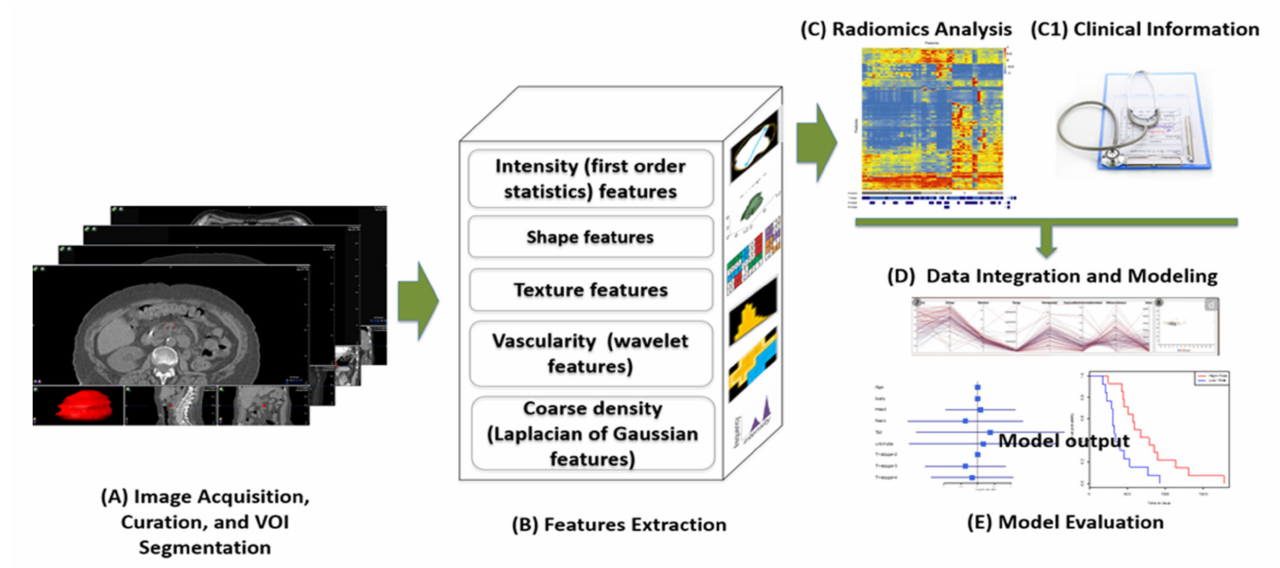
Figure 3. In a typical radiomics workflow, medical images are acquired and curated and volumes of interest (VOIs) such as pancreatic tumors are segmented ( A ). From the segmented VOI images, hundreds to thousands of radiomic features are then be extracted ( B ). After conducting preliminary radiomics analysis such as feature selection ( C ) and possibly adding clinical and biological infor- mation (C1), all features can be integrated through advanced statistical and/or machine learning methods to develop predictive models ( D ). The model accuracy and robustness can then be evaluated on validation and testing datasets ( E